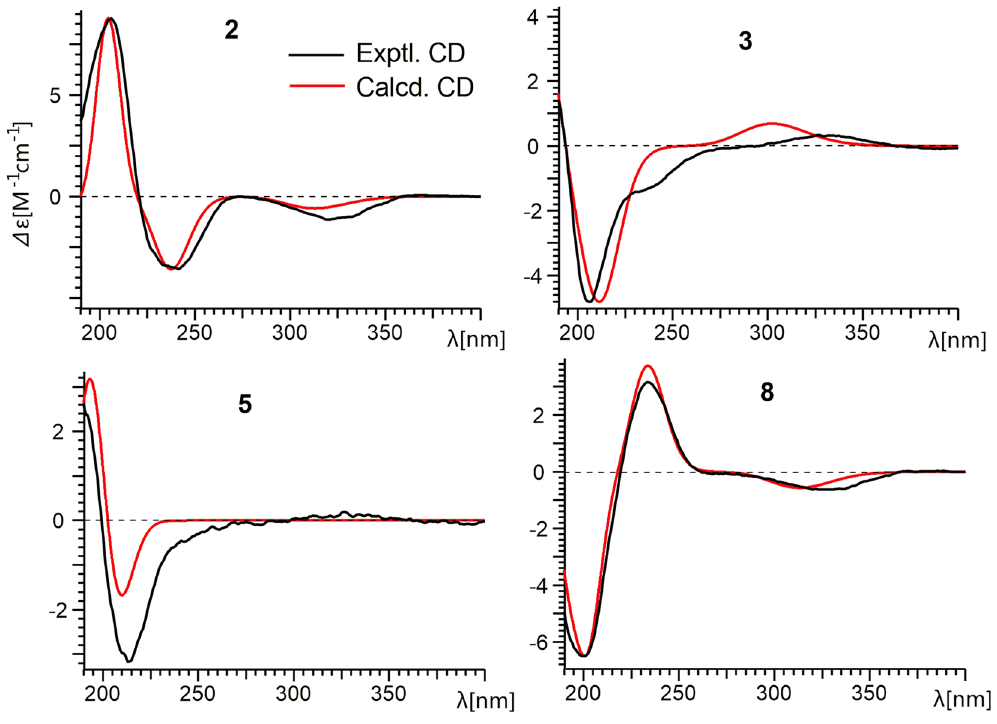
Figure 4. Experimental and theoretical ECD spectra of 2 , 3 , 5 and 8